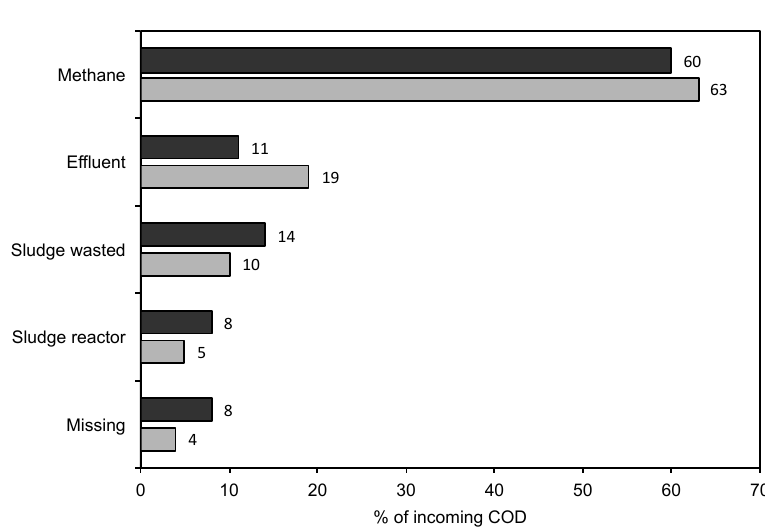
Figure 2. Chemical oxygen demand (COD) mass balance of the UASB reactors over the total period of operation (490 d for the black water (BW)-UASB reactor and 498 d for the MIX-UASB reactor).